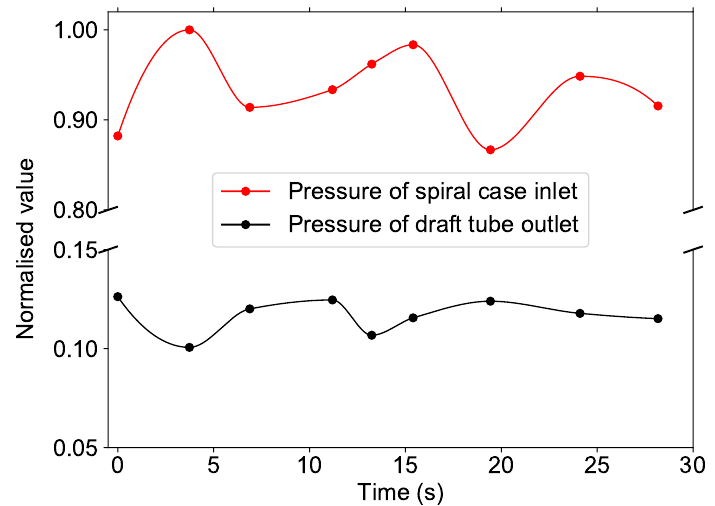
Figure 3. Normalized pressure at the spiral case inlet and draft tube